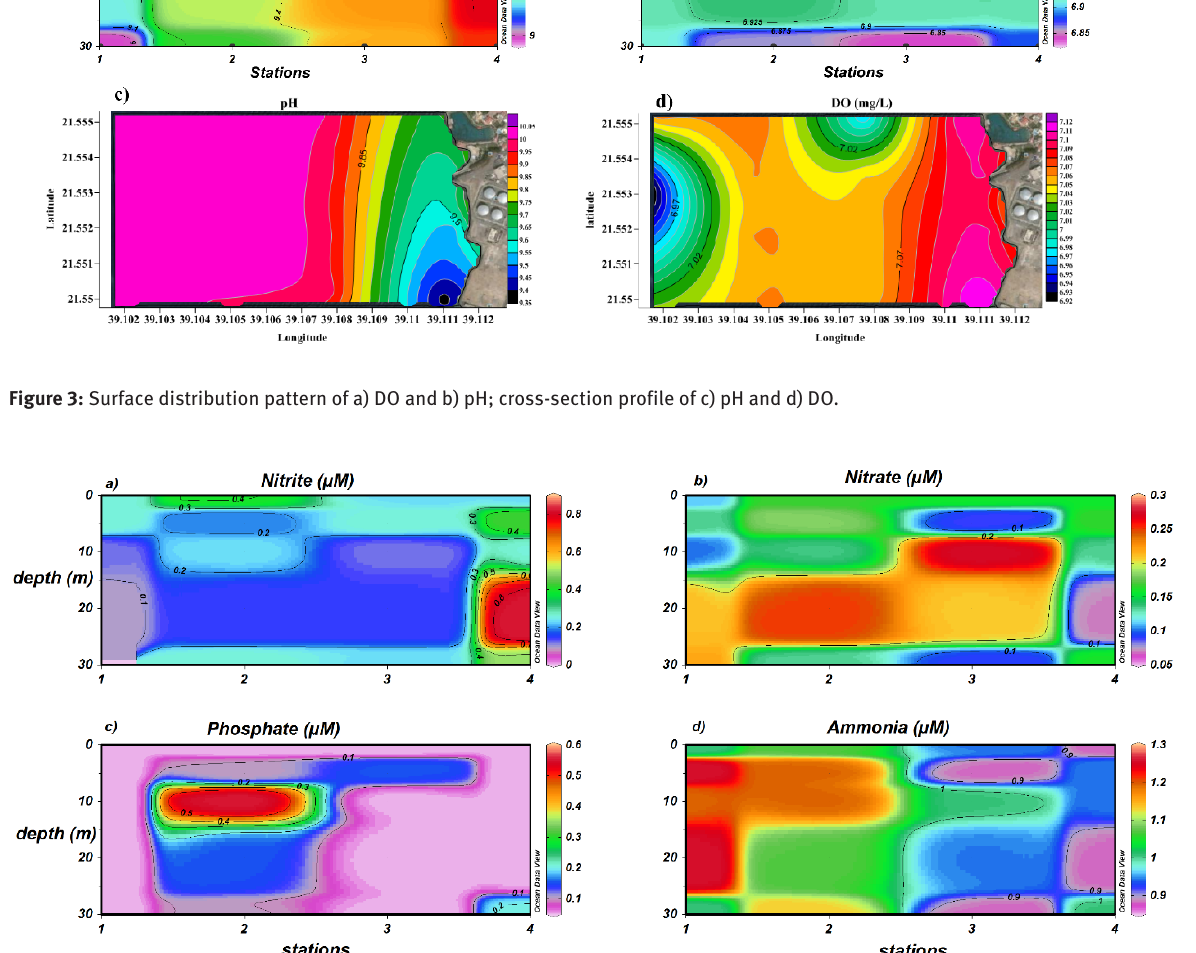
Figure 4: Cross-section profile of a) nitrite, b) nitrate, c) phosphate, and d) ammonia.